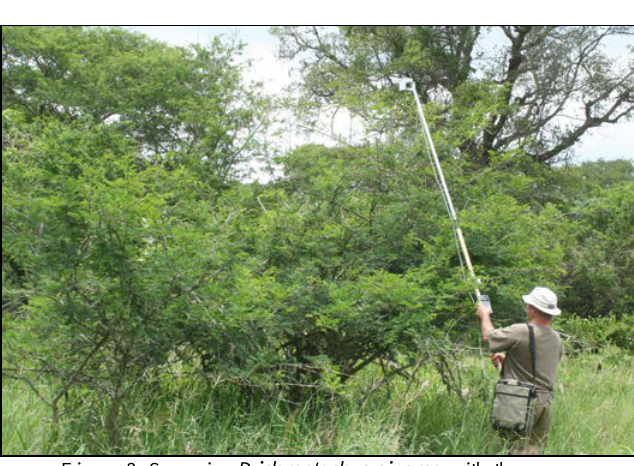
Figure 8: Scanning Dichrostachys cinerea with the multispectral radiometer. (Source M Jordaan, 2011) 4 RESULTS